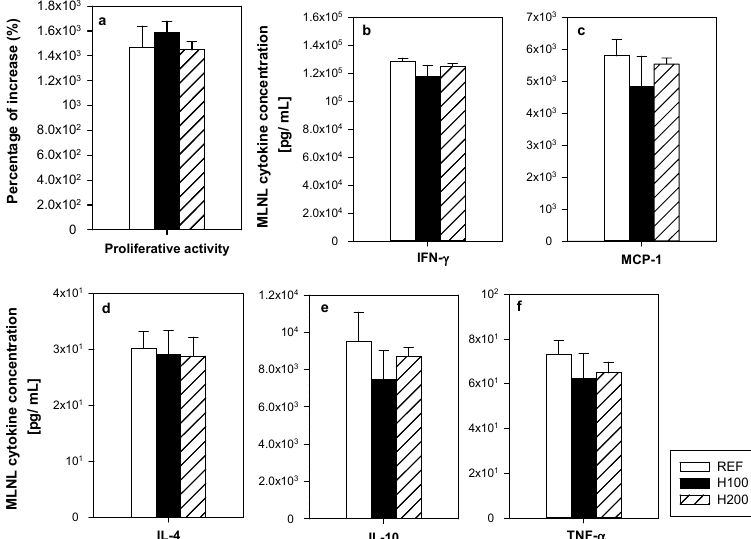
Figure 4. Effect of hesperidin administration on ( a ) the mesenteric lymph node lymphocyte (MLNL) proliferative activity; and ( b – f ) cytokine release by MLNL after anti-CD3/CD28 stimulation. Data are expressed as mean ± standard error ( n =